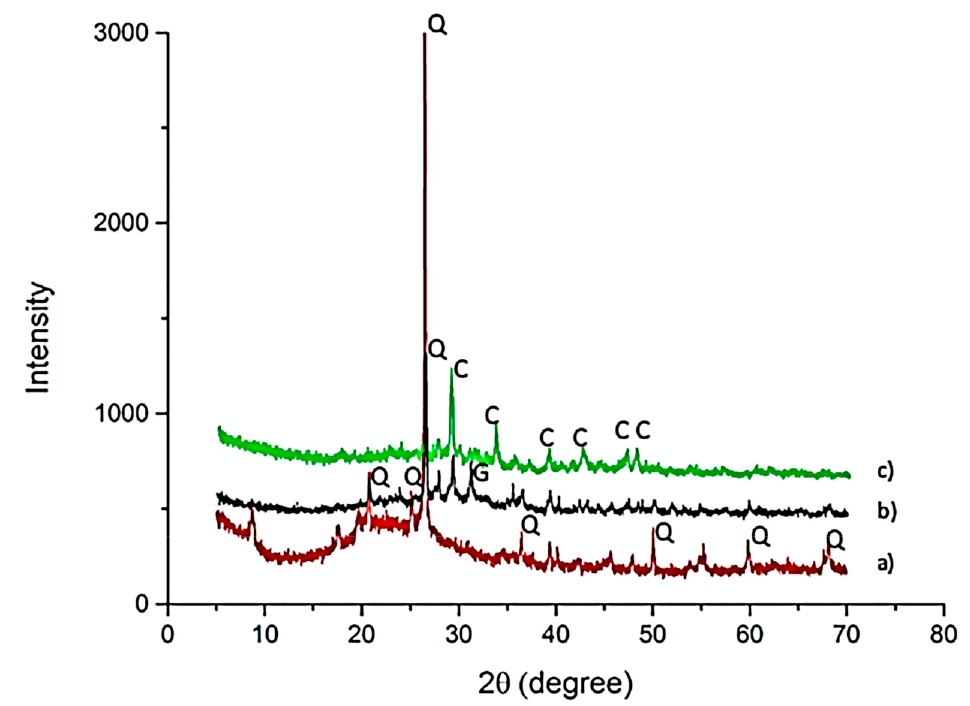
Figure 4. XRD patterns of raw materials: Metakaolin (a), IBA (b) and Biochar (c) (Q = Quartz; C = Calcite; G =